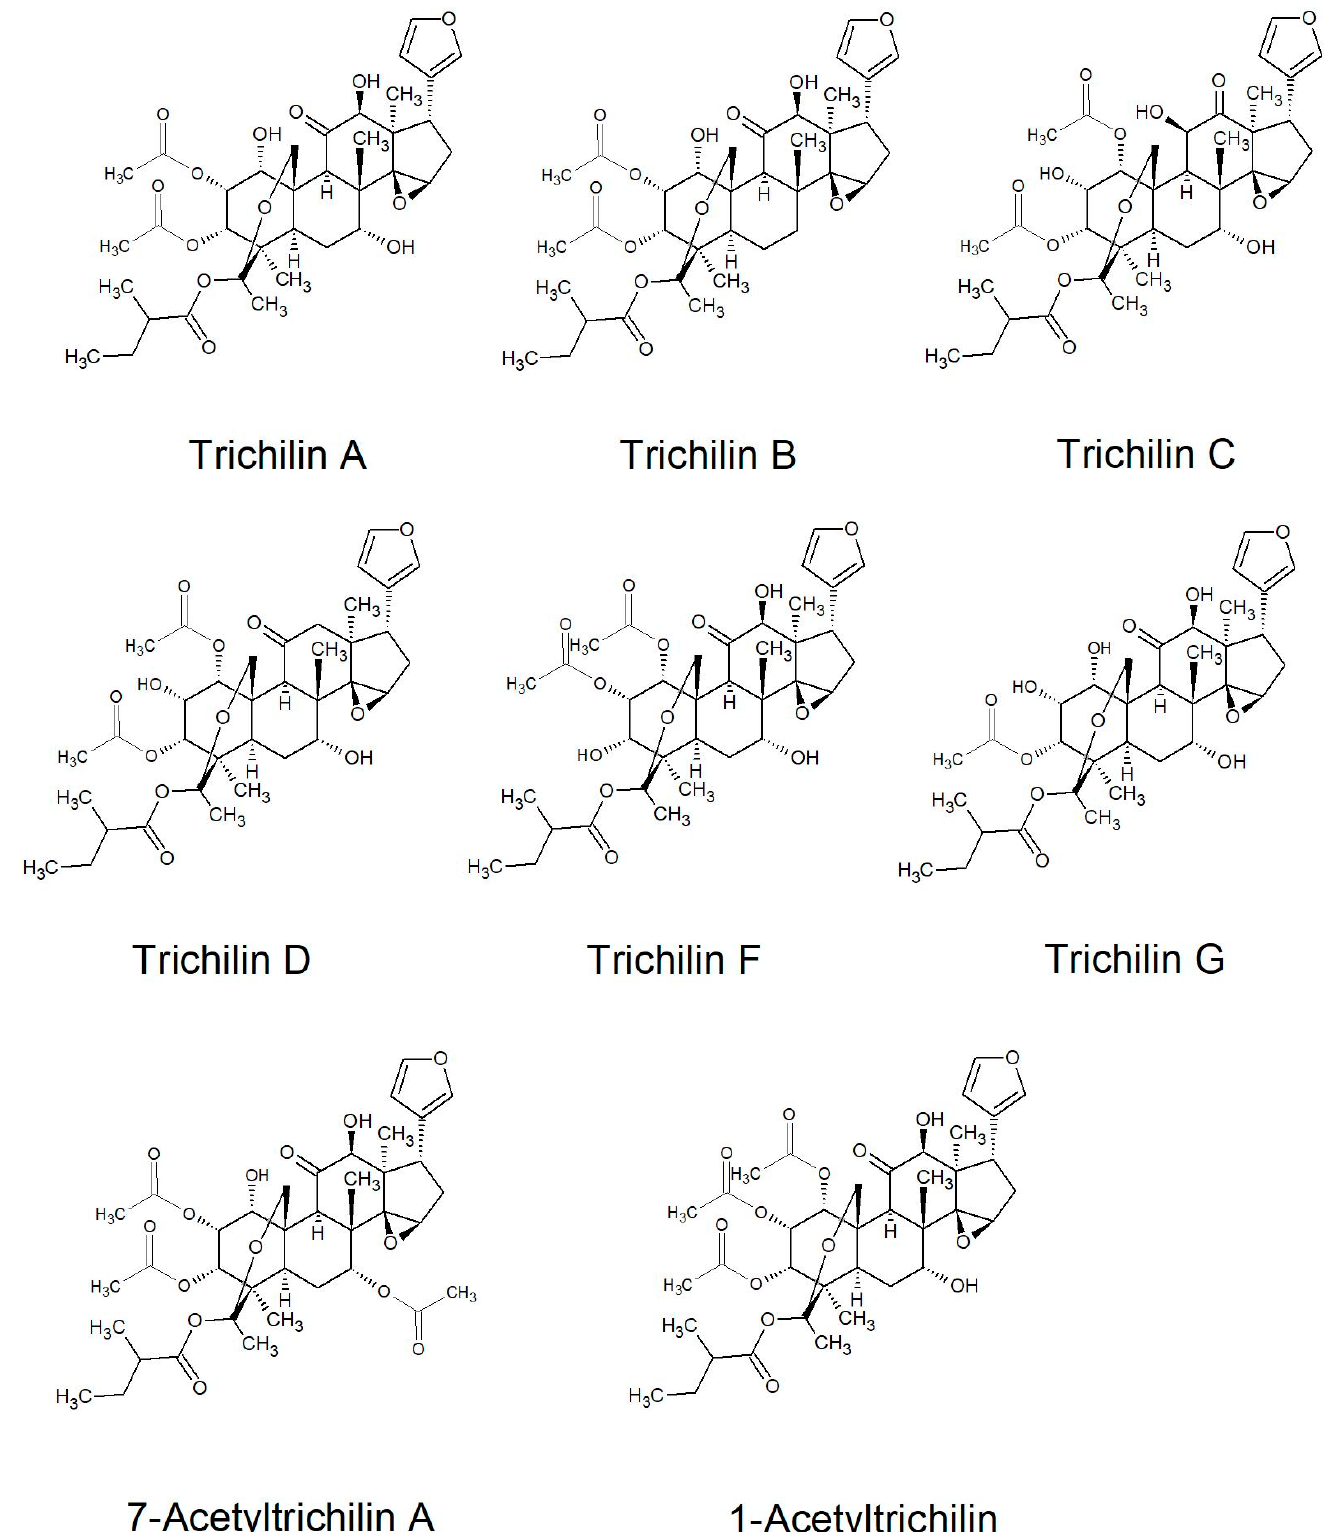
Figure 15. Trichilin series of limonoids reported from South African Meliaceae [137–139].